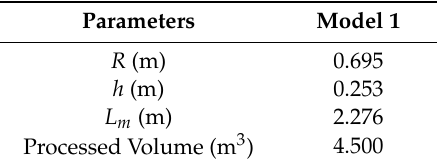
Table 1. Main geometrical parameters of the experimental mixer.